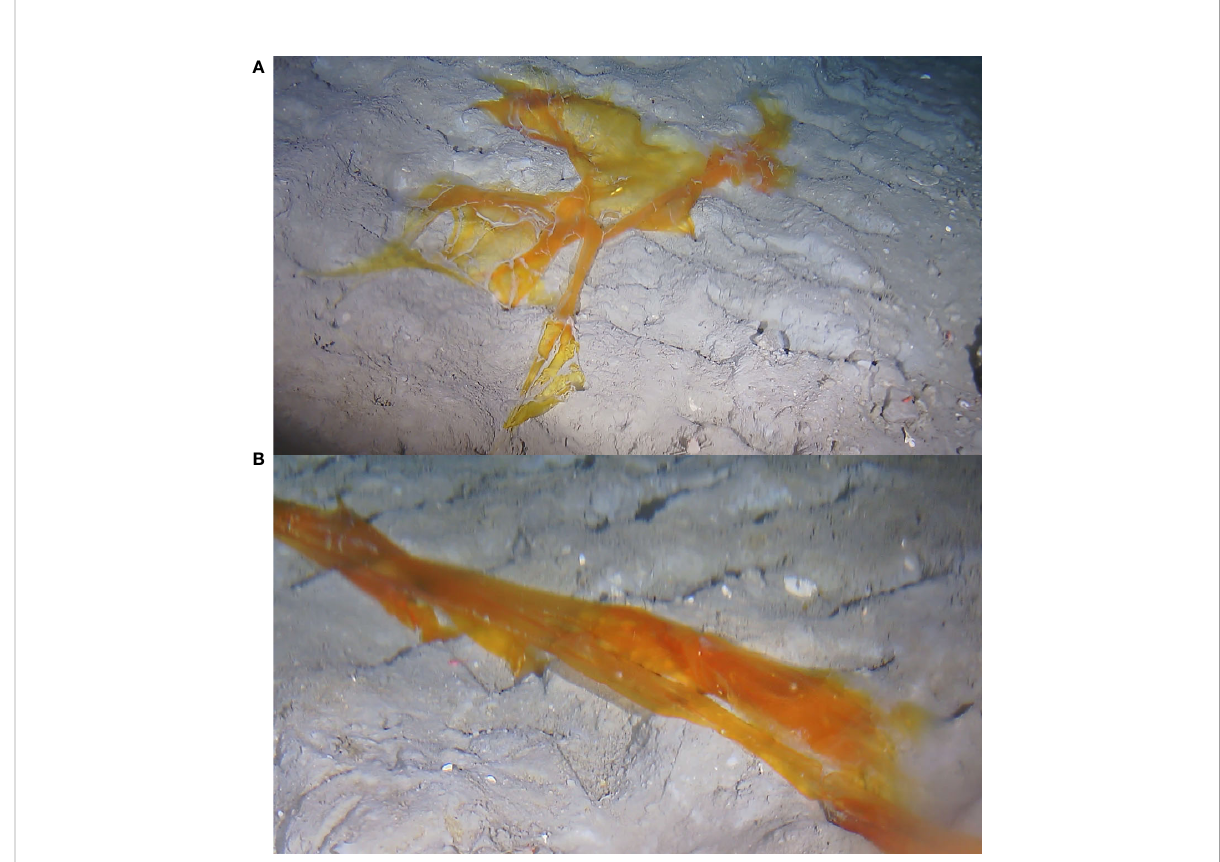
FIGURE 6 Piece of macroalgae, vertically transported to the hydrates site from the surface layers of Barkley Canyon. (A) Three days after the fi rst sighting (image taken on August 31 2021). (B) Five days after the fi rst sighting on the seabed (image taken on September 02